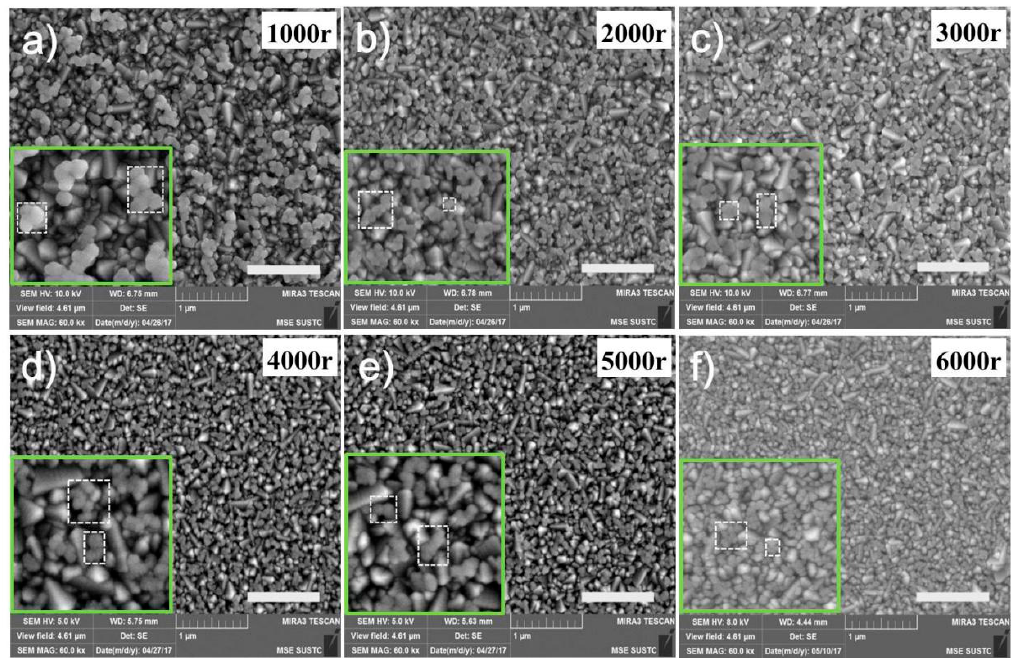
Figure 4. The morphologies of the CIGS thin film at different spin-coating rates on the FTO substrate. ( a ) 1000 r.p.m., ( b ) 2000 r.p.m., ( c ) 3000 r.p.m., ( d ) 4000 r.p.m., ( e ) 5000 r.p.m., ( f ) 6000 r.p.m. Scale bar is 1 µm.